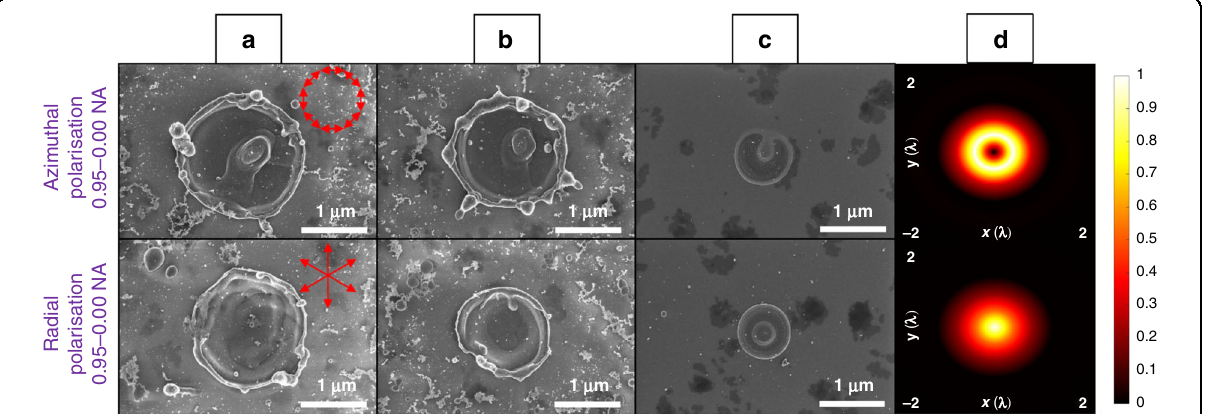
Fig. 2 A comparison of azimuthal and racial polarisation effect on single pulse laser ablation on silicon at different pulse energy. Full aperture Gaussian beam single pulse ablation on polished silicon with azimuthal and radial polarisation under the pulse energy of a 210 nJ, b 120 nJ, and c 30 nJ, with a 0.95 NA objective lens. d The relative modelling of the beam intensity cross-section of the azimuthal and radial